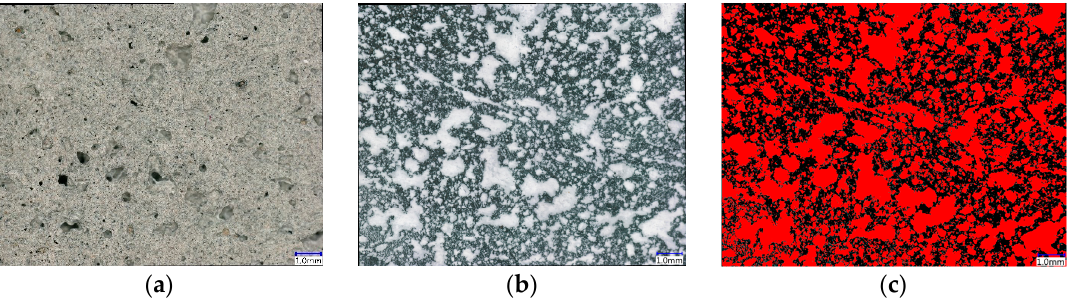
Figure 6. Typical initial image and sequence of processed images of foam concrete: ( a ) polished specimen, ( b ) colored image, ( c ) binary image processed for computational measurements of air-void parameters.